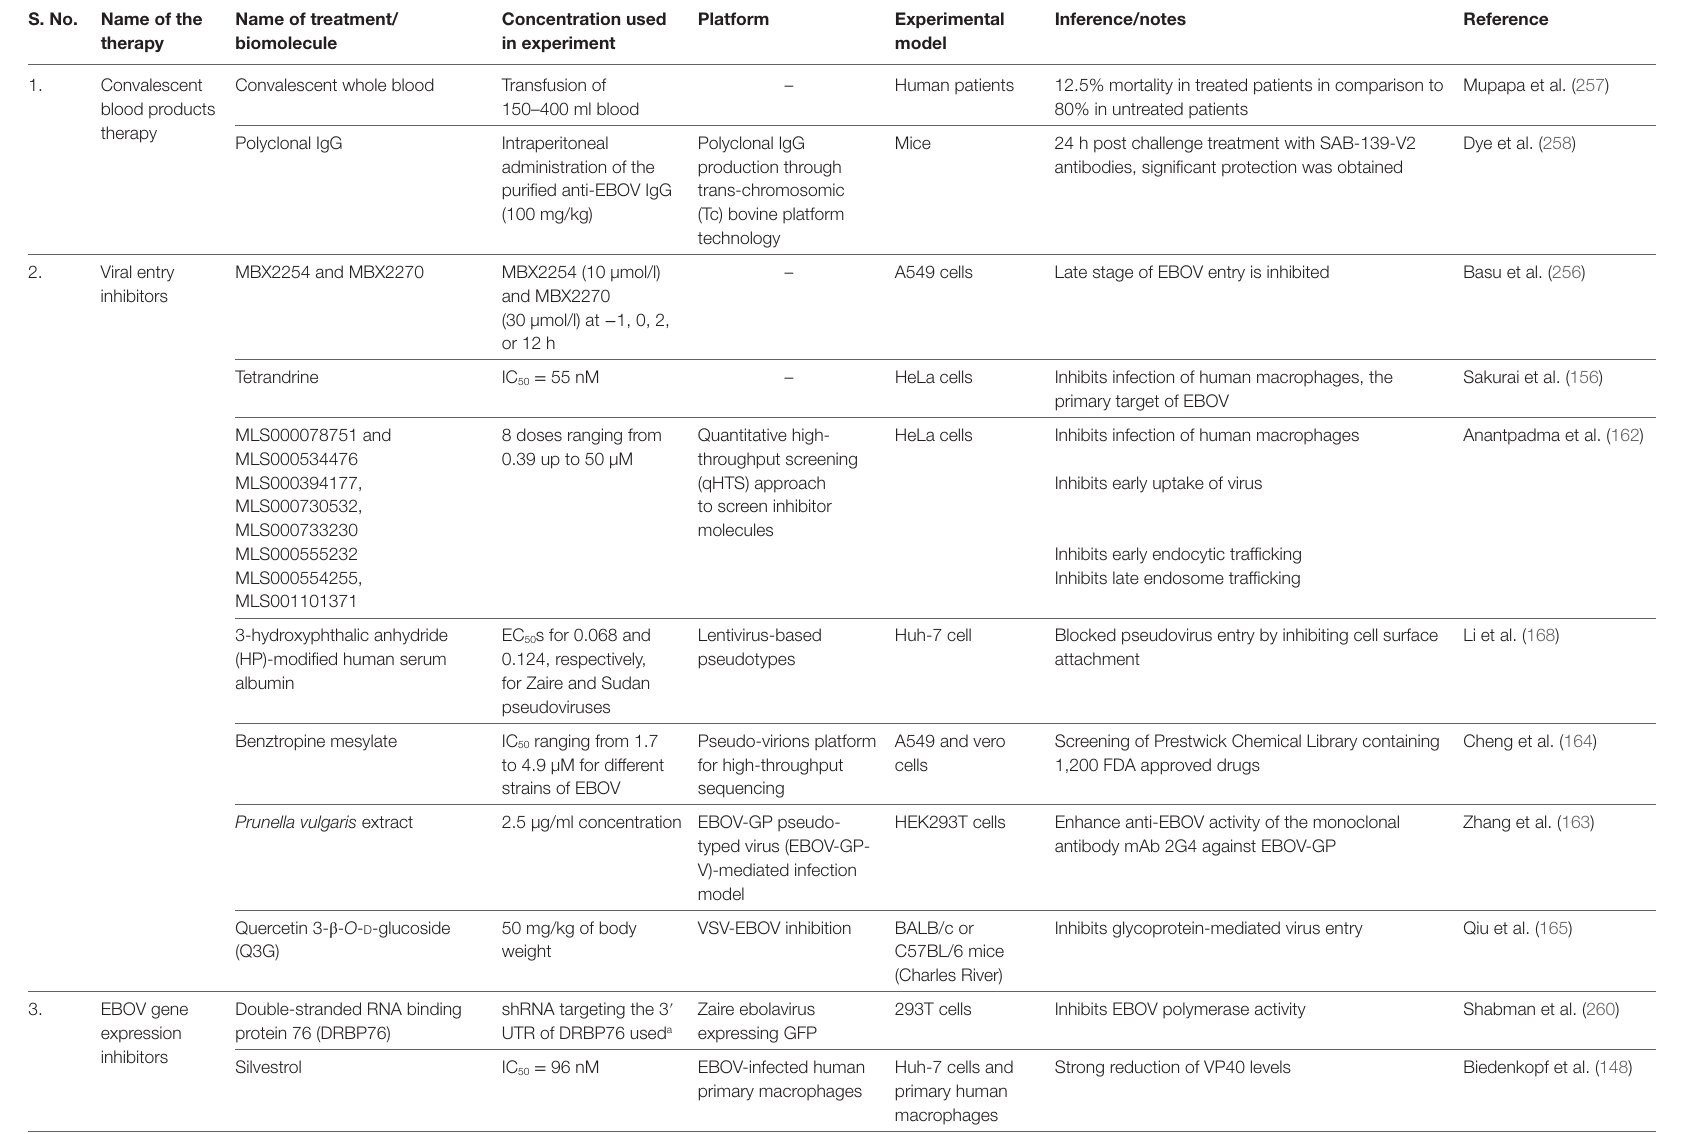
TABLe 3 | Investigated drugs/biomolecules to treat Ebola virus (EBOV) infection. S. No. Name of the